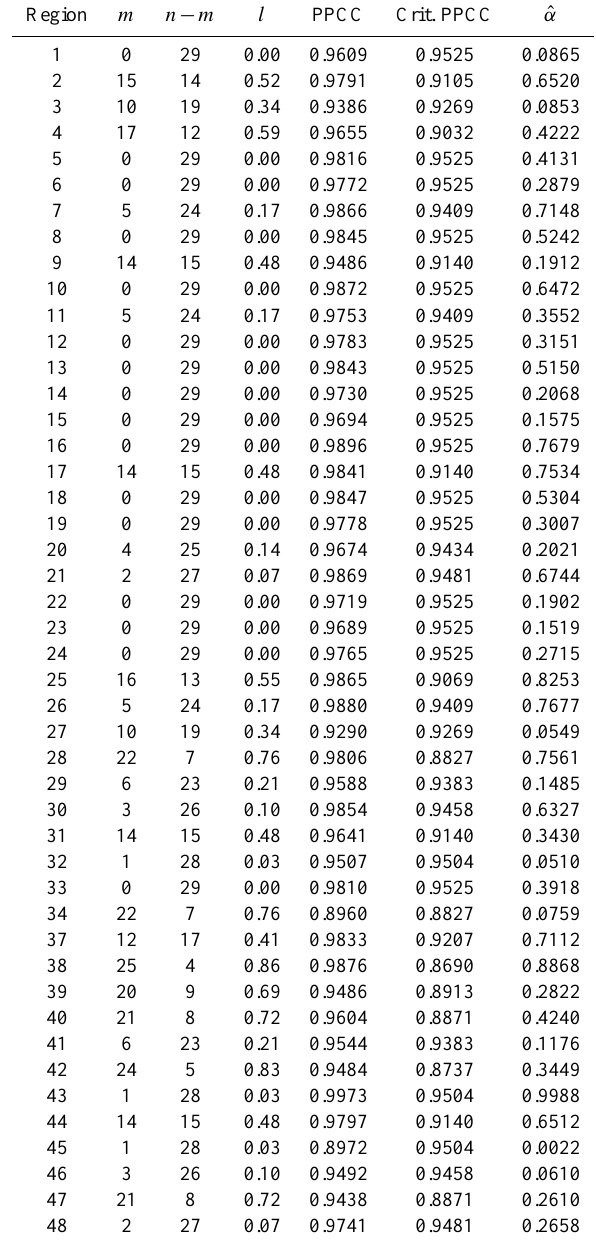
Table 4. Summary statistics of the global CMT catalog